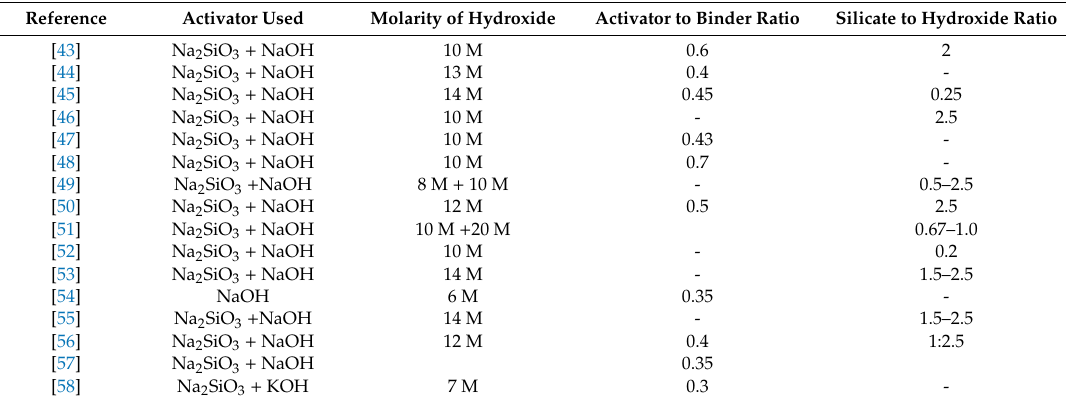
Table 2. List of alkaline activators with various dependent